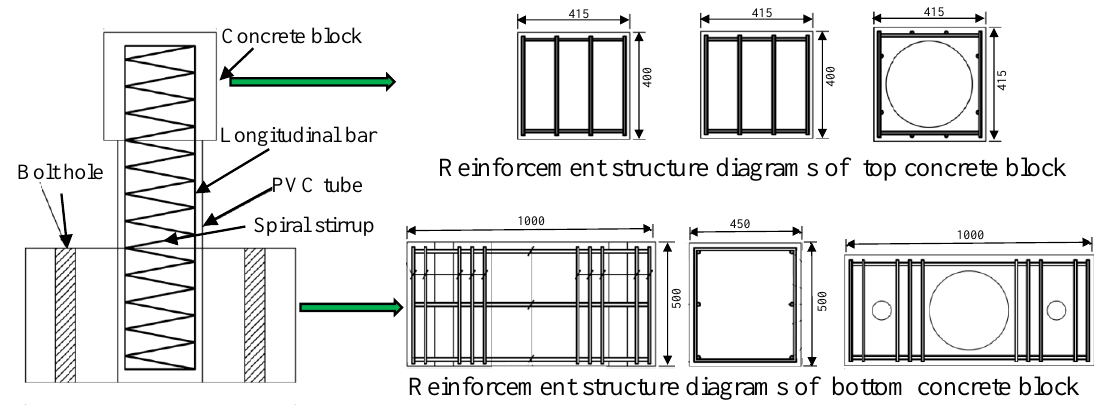
Figure 4. The structure diagrams of a concrete short column in detail.